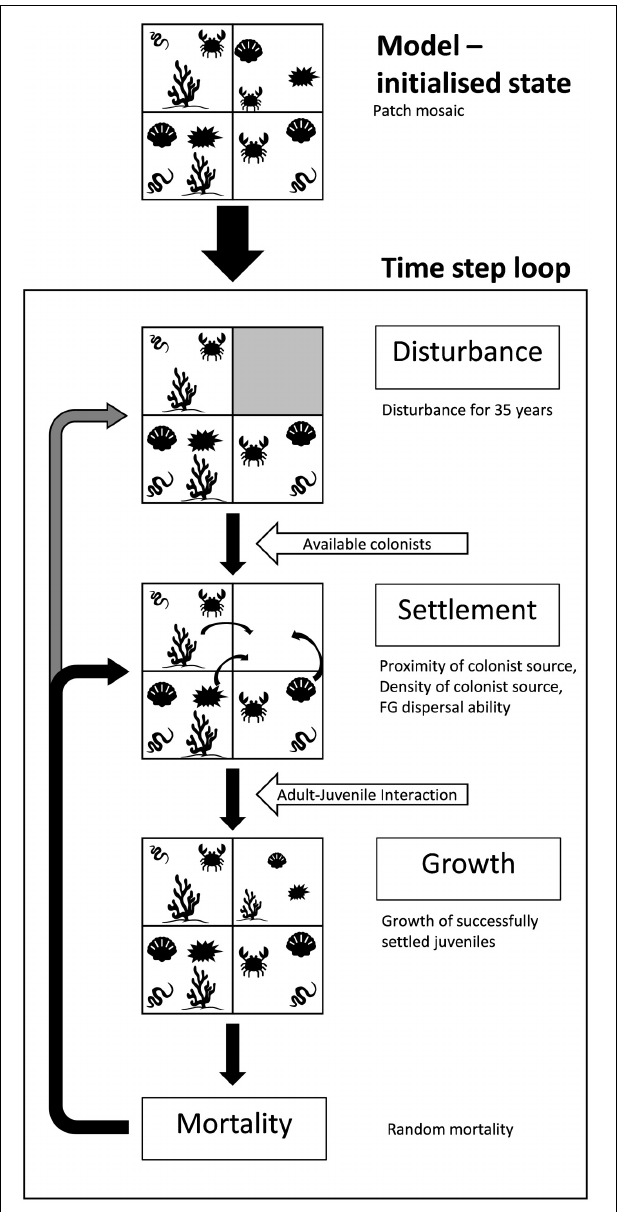
FIGURE 1 | Flow chart of the spatially explicit seafloor disturbance model and schematic of conceptual seafloor patches undergoing disturbance and recovery (adapted from Lundquist et al., 2010; Lundquist et al.,